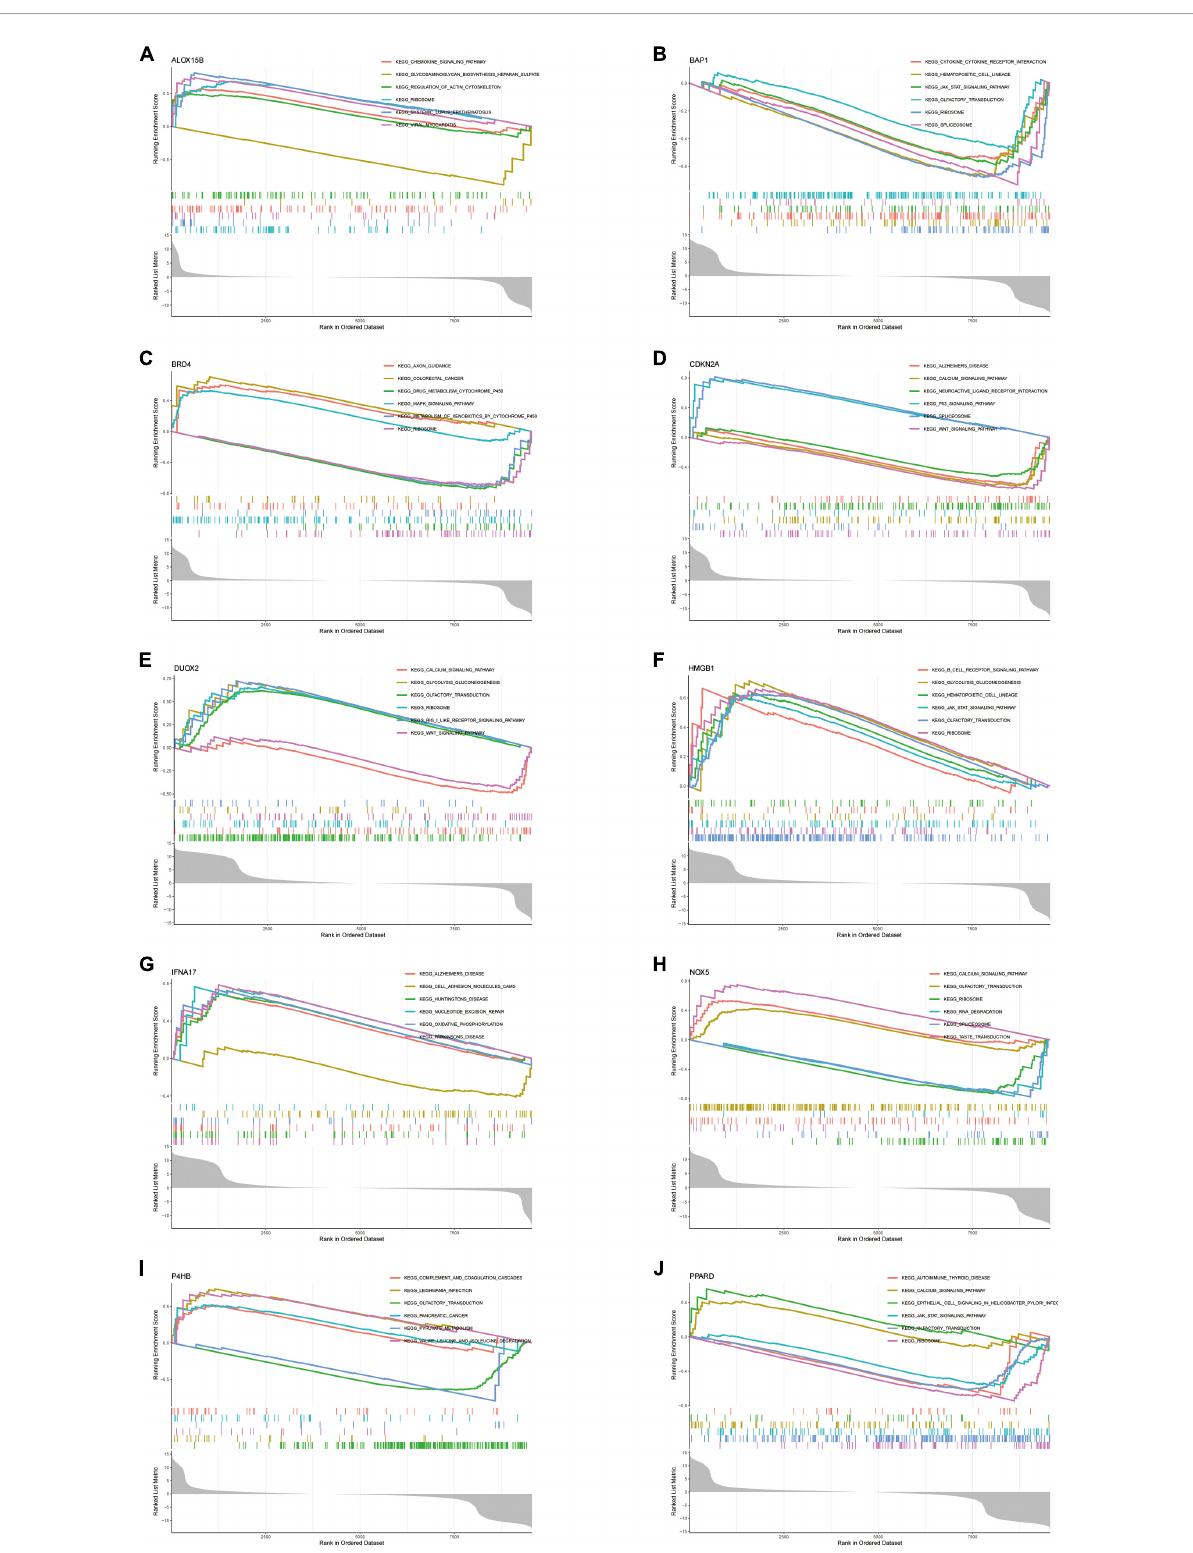
FIGURE9 (A–J) Single-gene GSEA-KEGG pathway analysis in ALOX15B (A) , BAP1 (B) , BRD4 (C) , CDKN2A (D) , DUOX2 (E) , HMGB1 (F) , IFNA17 (G) , NOX5 (H) , P4HB (I) , PPARD (J)